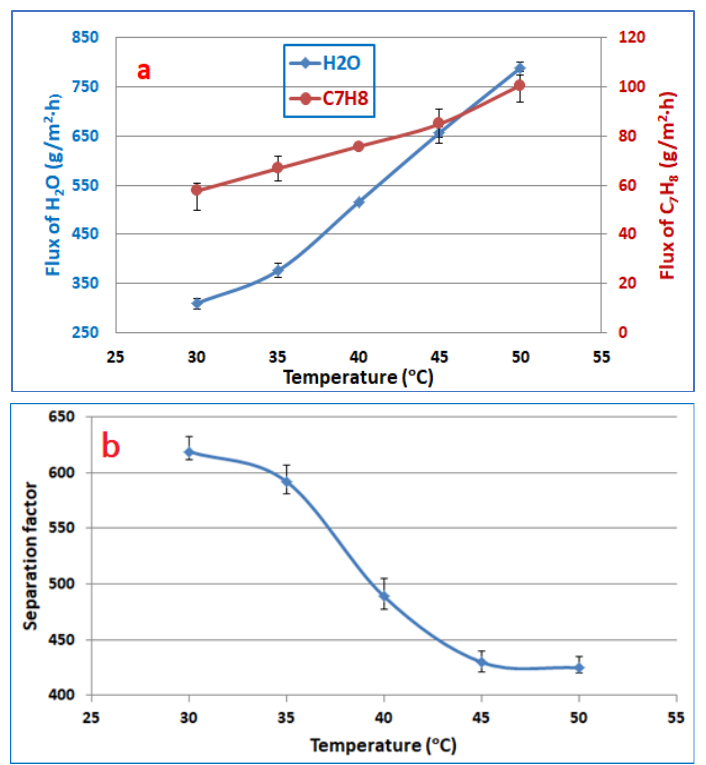
Figure 2. Effect the temperature on ( a ) fluxes of toluene and water, ( b ) separation factor, at toluene feed concentration of 300 ppm and 3 L/min feed flowrate.